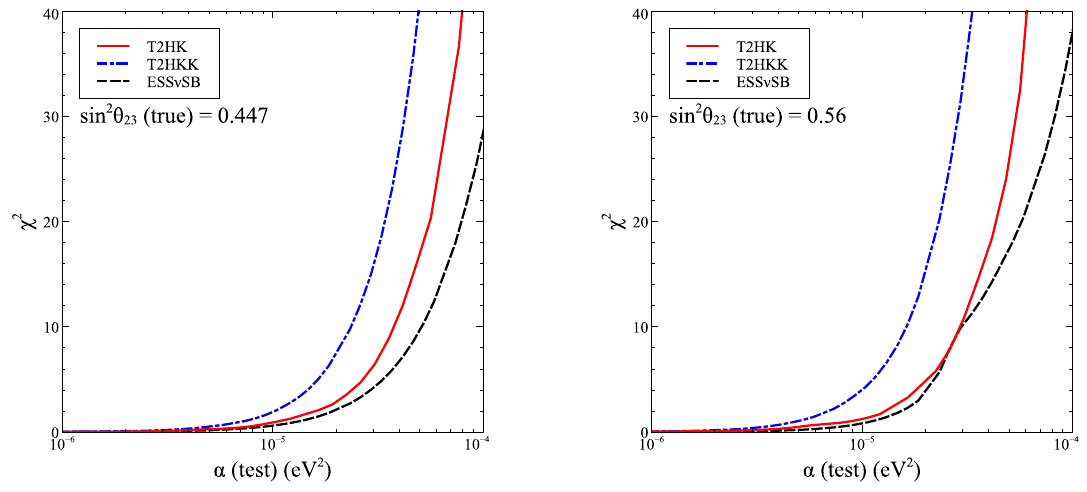
Figure 3 . The χ 2 as a function of α , assuming no decay in the simulated data. The left (right) panel is for θ 23 (true) in the lower (higher) octant. The red solid, blue dashed dotted and the black dashed curves are for T2HK, T2HKK and ESS ν SB